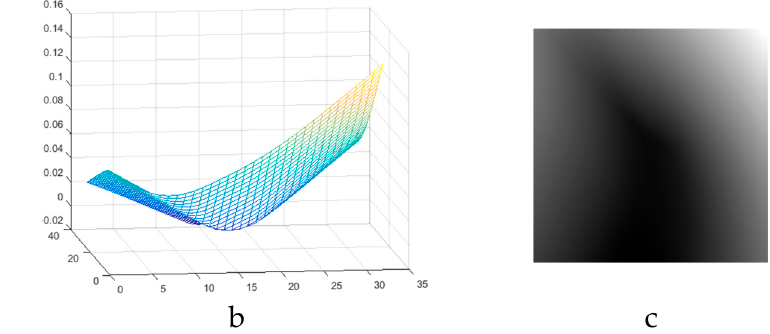
Figure 2. Adaptive modification of tactile sensor size.